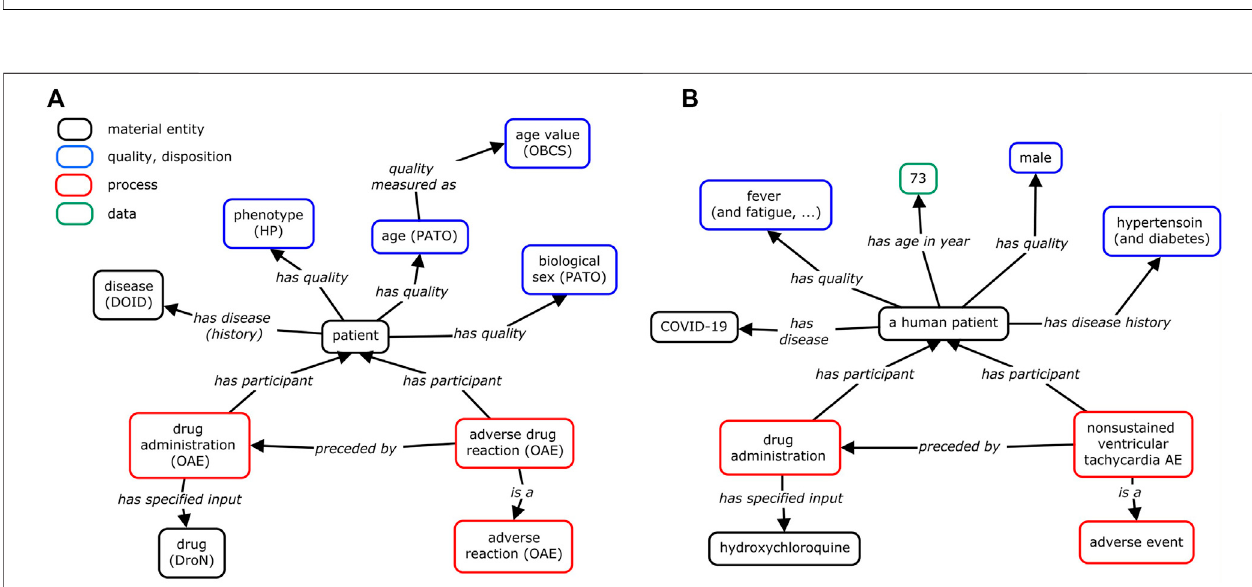
FIGURE6| Modelingofcondition-dependentAEoccurrencewithanexamplepublishedinPubMed. (A) Generalmodeling. (B) HCQAEcasestudyexample.Inthis example,ahumanpatientwithCOVID-19wastreatedwithHCQ,andlatersufferedfromunsustainedventriculartachycardiaAE(Abdelmaseihetal.,2020).Inadditionto thepositiveCOVID-19diagnosis,thestudyoftheHCQAEneedstoconsiderthepatient ’ sage(75 yearsold),biologicalsex(male),medicaldiseasehistory(hypertension and diabetes), and the symptoms (e.g., fever, dry cough) before the usage of the HCQ drug. If these conditions had changed, the cardiac disease might have not occurred. To support ontology interoperability, OAE also reuses terms from other ontologies, including Human Phenotype Ontology (HP) (Kohler et al., 2021), Drug Ontology (DrON) (Hanna et al., 2013), disease Ontology (DOID) (Schriml et al., 2012), Phenotype And Trait Ontology (PATO) (Mabee et al., 2007), and Ontology of Biological and Clinical Statistics (OBCS) (Zhenget al., 2016). The relation “ has age (in year) ” is ashortcutrelation of ( “ has quality ” some (age and “ quality measured as(in year) ” )). This method of ontology modeling allows us to better visualize the many factors that contribute to the manifestation of certain AEs.